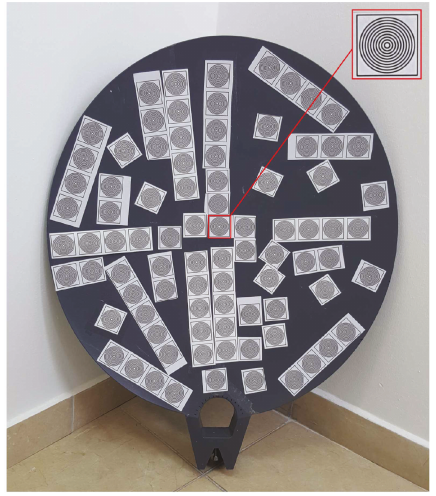
Figure 4: The multicircular targets on a solid main re fl ector as acquired by the monocamera.